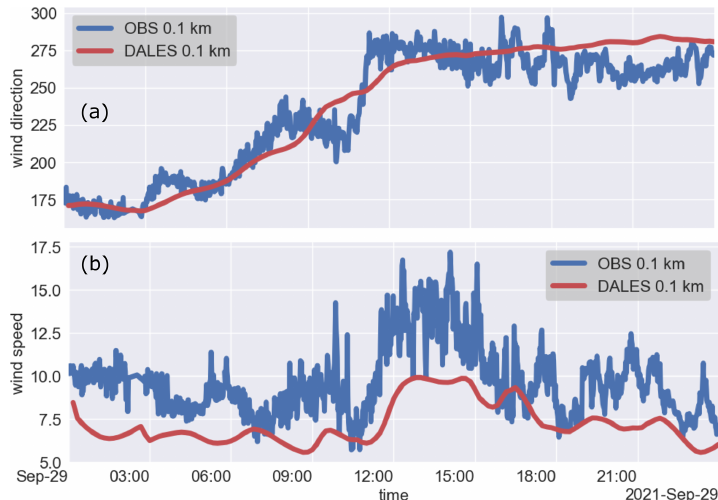
Figure 16. Time series of wind direction (panel a ) and speed (panel b ) from 29 September 2021 at 0.1km above the surface. The blue curve is from the lowest available observation in the CMTRACE level 2; the red is from DALES.